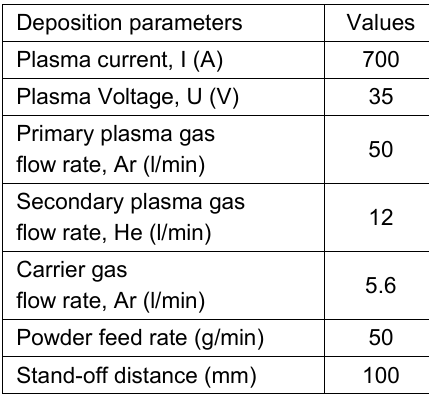
Tabela 1 – Plazma sprej